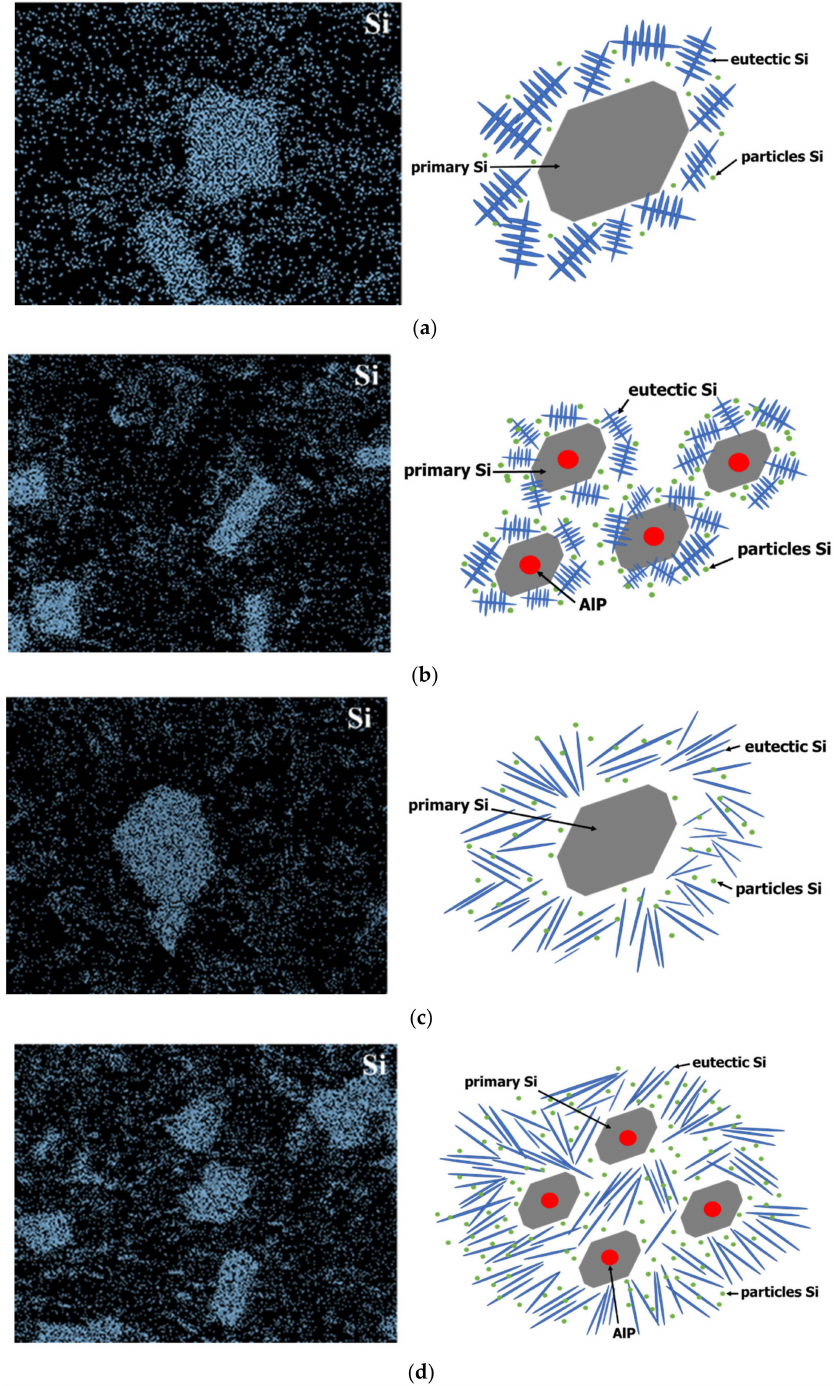
Figure 9. EDS mapping shows the concentration and dispersion of silicon along with the intermetallic phase model in ( a ) unmodified B390 ( b ) B390-0.1P ( c ) B390-1.0Bi, and ( d )